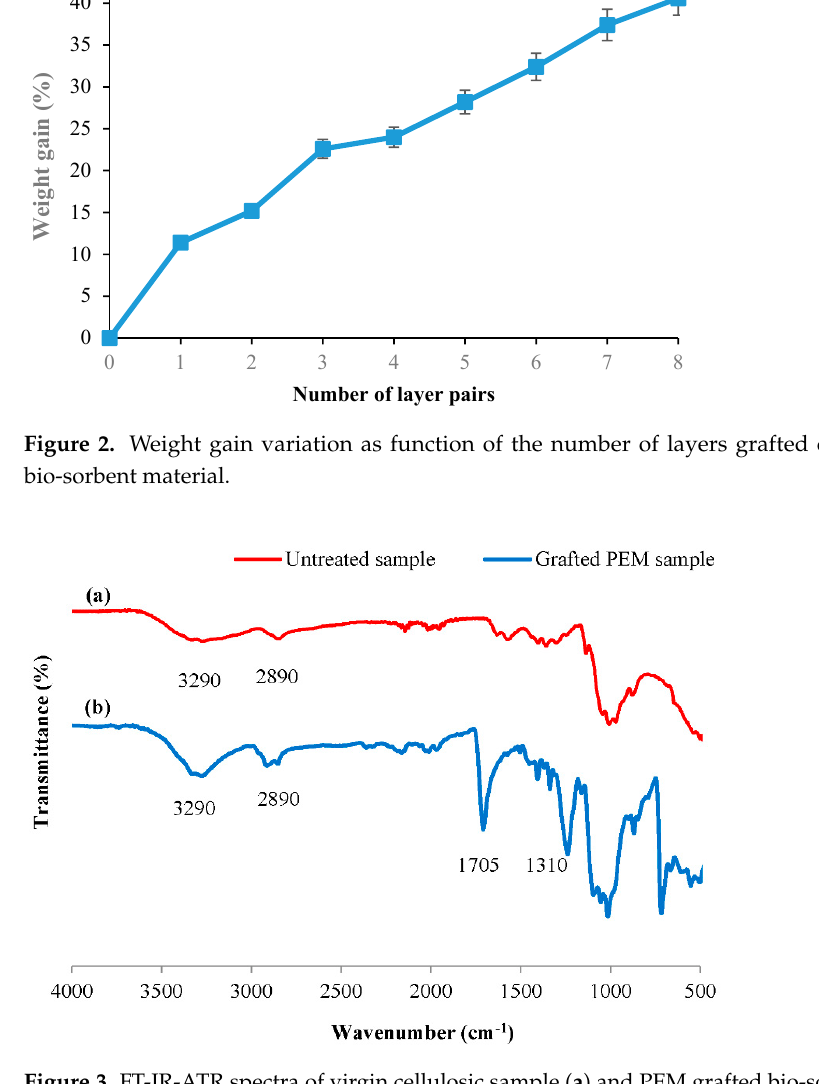
Figure 3. FT-IR-ATR spectra of virgin cellulosic sample (a) and PEM grafted bio-sorbent material